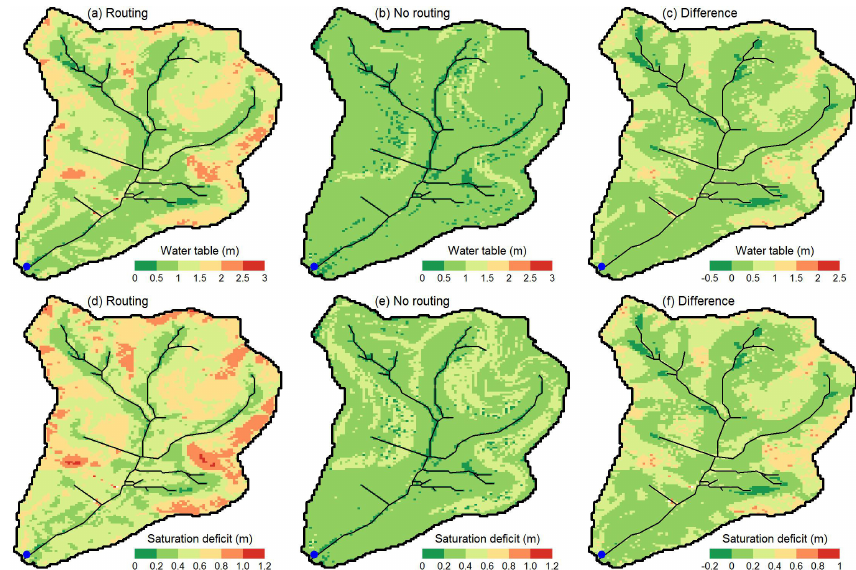
Fig. 3. Comparison of simulated monthly average daily soil water table depth and saturation deficit in July 1994 between the two contrasting simulations: (a) and (d) considered water routing while (b) and (e) ignored water routing. (c) and (f) show differences in simulated soil water table depth and saturation deficit between the two contrasting simulations.